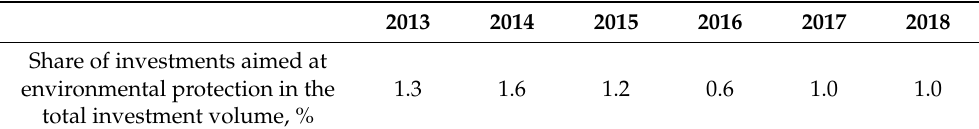
Table 1. Dynamics of the share of investments aimed at environmental protection and related to the green economy for